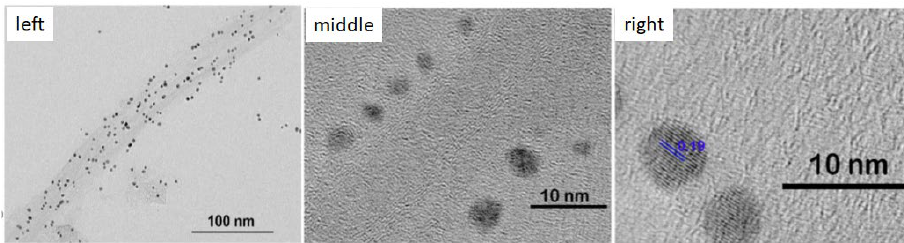
Figure 5. TEM ( left ) and high-resolution TEM images ( middle and right ) of hybrid materials Ag@( P12 noncovalently interacting with carbon nanotubes), where the average diameter of Ag nanoparticles is around 3–4 nm [86]. Copyright © 2022 by Elsevier.